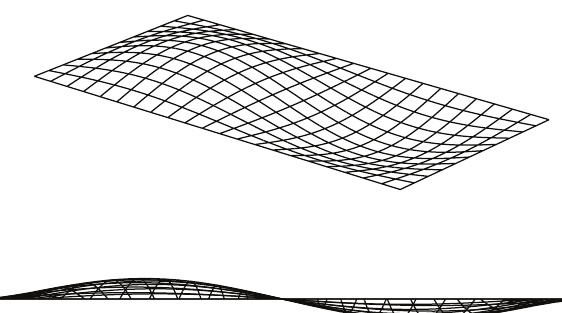
Figure 4: Configuration of the initial deflection in the